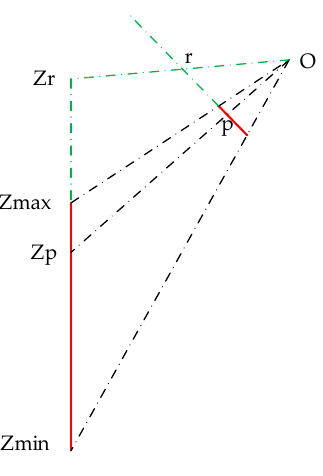
Figure 4. Calculation of the minimum pixel-wise back-projected distance according to cross ratio projective invariance theory. The elevation range is from Z min to Z max; Zr is a point along the vertical line in the object space and r is the projected points of Zr in the photo space; p is a pixel-wise point and the minimal pixel-wise back-projected distance is Δ Z = Z max- Zp .